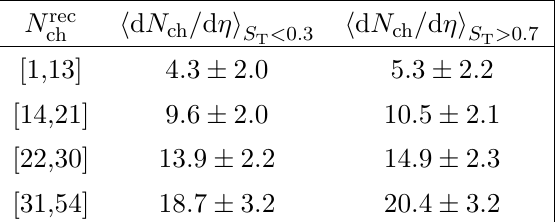
and corresponding mid-rapidity h d N ch = d (cid:17) i with j (cid:17) j < 1 : 2 and 0 : 13 < Table 1 . Intervals of N rec ch p T < 4 : 0 GeV/ c for both sphericity